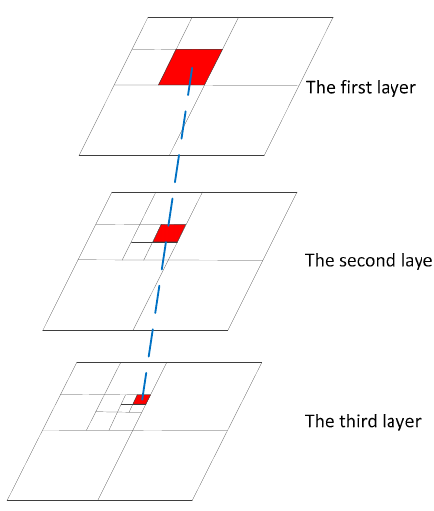
Figure 3. Pointing angle prediction with the pyramid strategy.